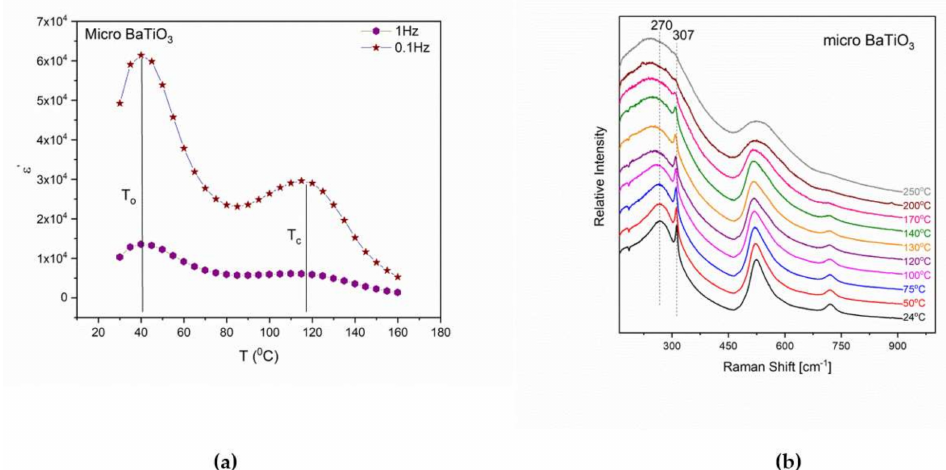
Figure 4. ( a ) Real part of dielectric permittivity as a function of temperature at 0.1 Hz and 1 Hz for micro-BT particles, and ( b ) Raman spectra for micro-BT particles in the temperature range from 24 ◦ C to 250 ◦